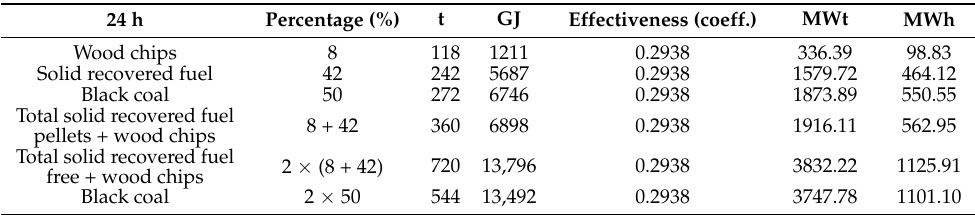
Table 8. Statistical conversion to 100% calorific value of solid recovered fuel and wood chips in recovered fuel.